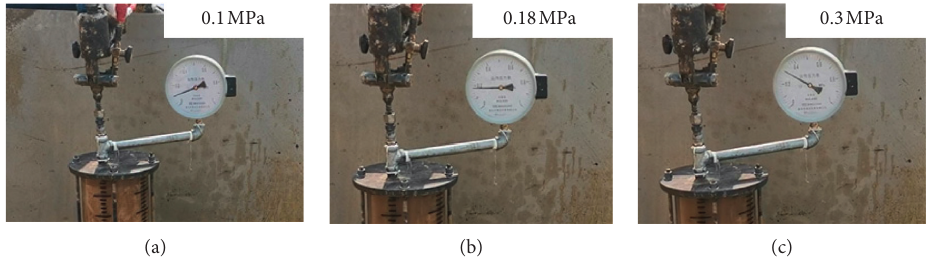
Figure 7: The pressure inside the die changes with time during the grouting under 0.3MPa. (a) 5s. (b) 10s. (c) 30s.